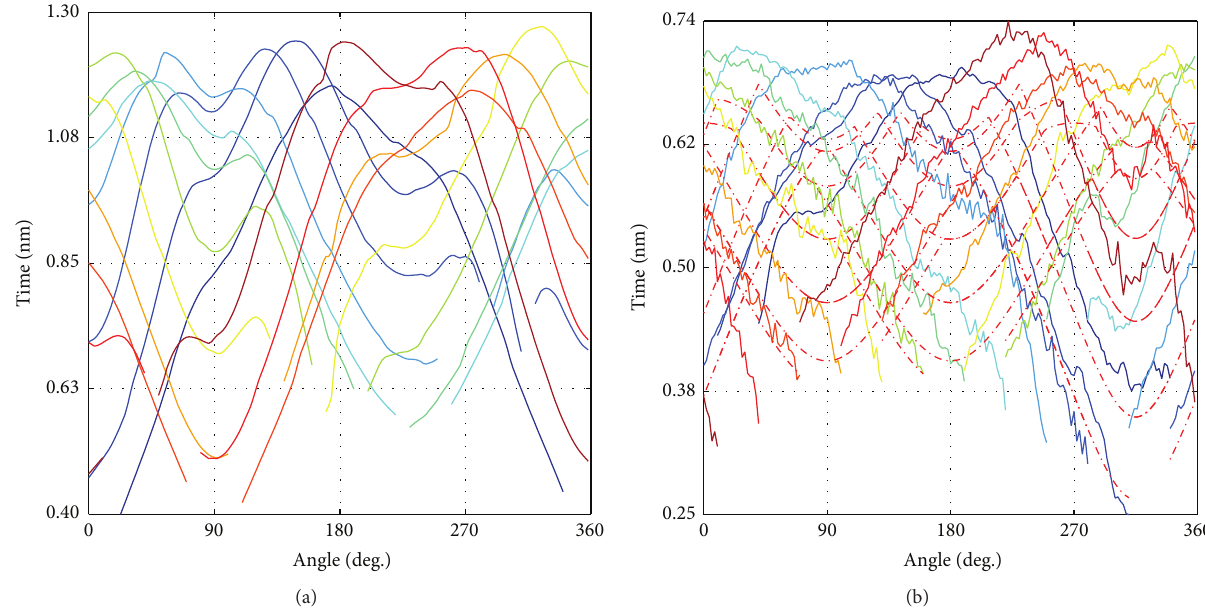
Figure 17: (a) EPAT projections measured with PMTs (these are the projections used to obtain Figure 11(c); each colored curve corresponds to a projection). (b) EPAT projections measured with SPADs corresponding to Figure